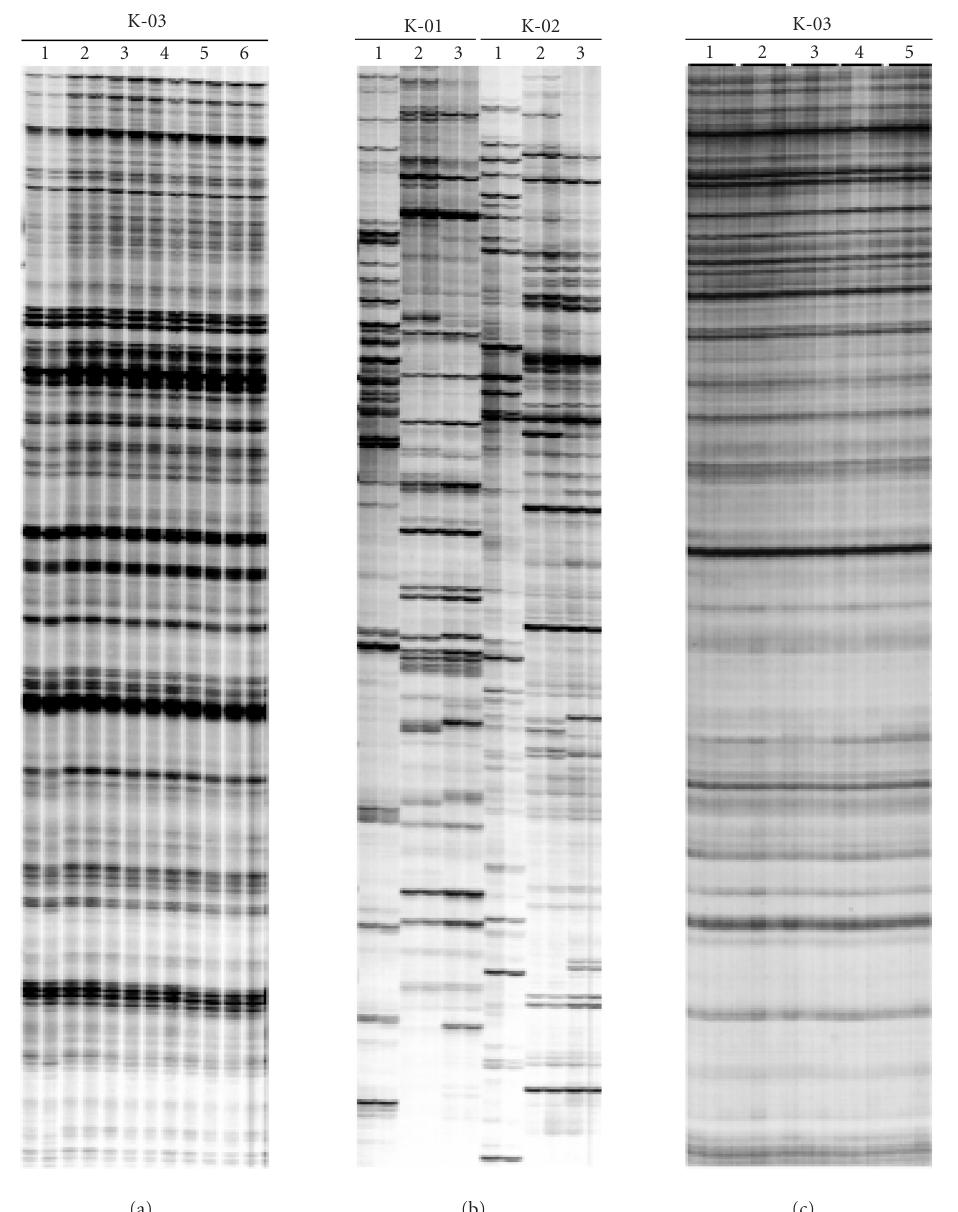
Figure 1. RAF profiles amplified from sugarcane (a), tomato and soybean (b), and wheat (c). Radio-labelled profiles amplified from replicate ((a) and (b)) or triplicate (c) genomic DNA extractions were run side-by-side on the gel and given the same lane number. The Operon oligonucleotide primers used are also listed above the lanes. (a) RAF profiles amplified from di ff erent amounts of genomic DNA extracted from sugarcane hybrid 79A362. Lanes 1, 12 . 5ng; lanes 2, 25ng; lanes 3, 50ng; lanes 4, 100ng; lanes 5, 250ng; and lanes 6, 500ng. (b) RAF profiles amplified from tomato cv. Moneymaker (lanes 1), Glycine soja (lanes 2), soybean ( G. max ) cv. Bragg (lanes 3). (c) RAF profiles amplified from wheat cv. Hartog; lanes 1–5 represent individual Hartog